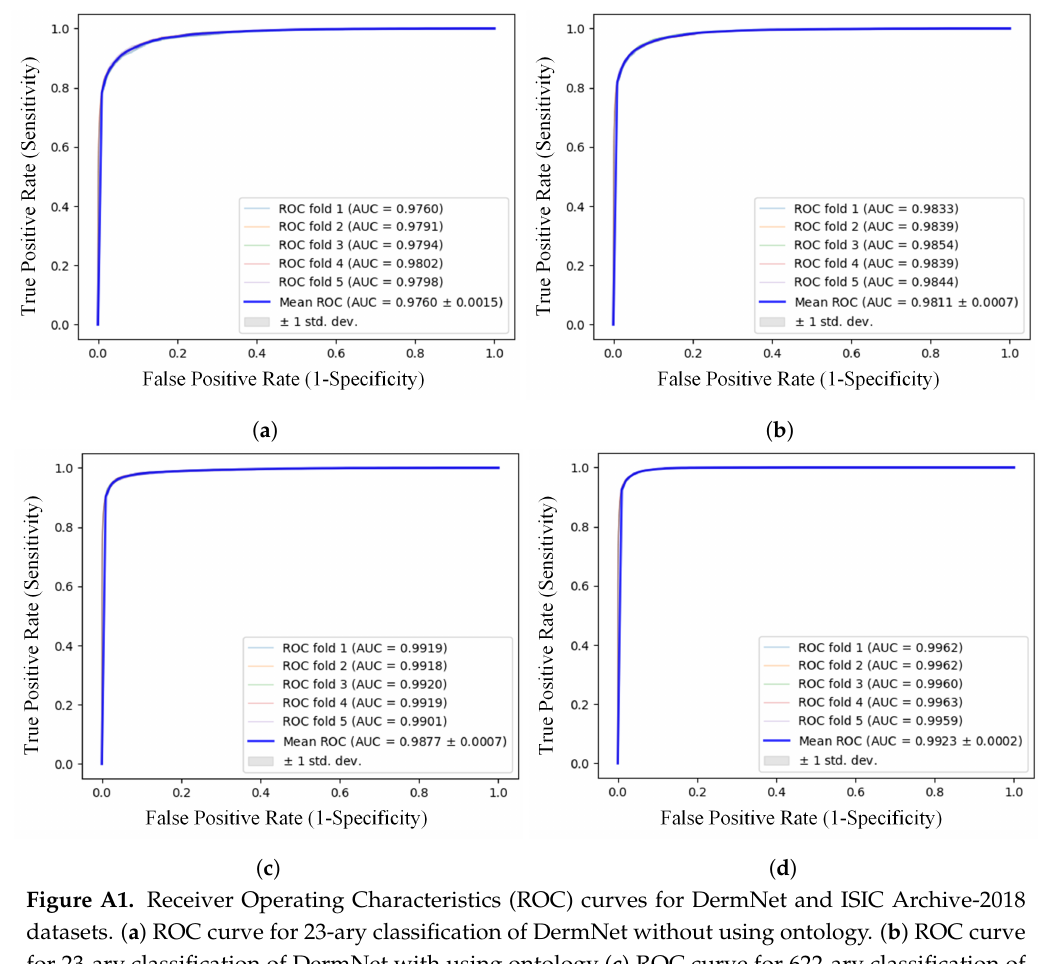
Figure A1. Receiver Operating Characteristics (ROC) curves for DermNet and ISIC Archive-2018 datasets. ( a ) ROC curve for 23-ary classification of DermNet without using ontology. ( b ) ROC curve for 23-ary classification of DermNet with using ontology ( c ) ROC curve for 622-ary classification of DermNet. ( d ) ROC curve for 622-ary classification of ISIC